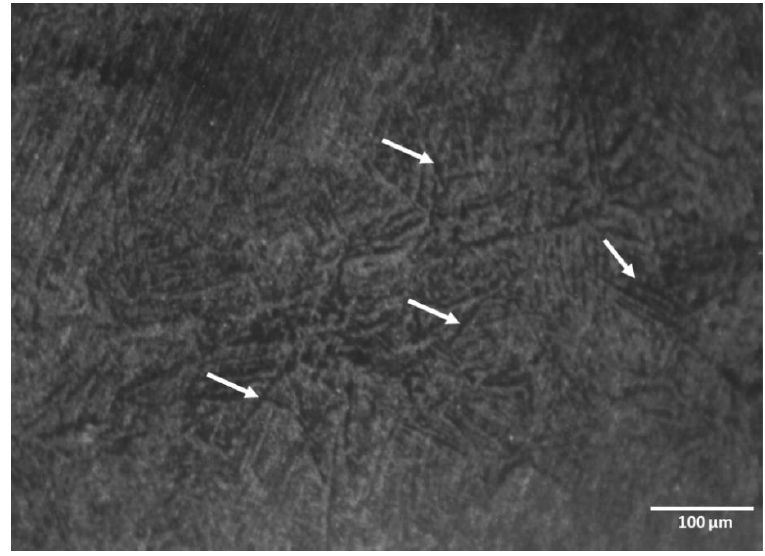
Figure 3. Optical micrograph of the sintered Ti sample.